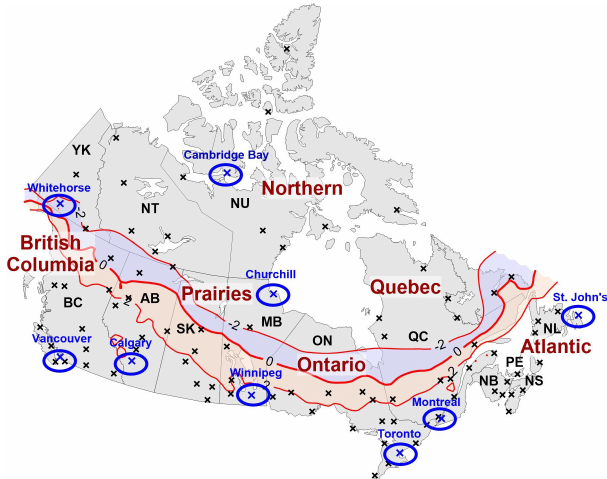
Figure 2. The 92 stations used in the analysis (see text for details). Blue crosses show the nine selected stations across Canada. The British Columbia region includes all stations in British Columbia (BC); the Prairies region includes all stations in Alberta (AB), Saskatchewan (SK), and Manitoba (MB); the Ontario region in- cludes all stations in Ontario (ON); the Quebec region includes all stations in Quebec (QC); the Atlantic region includes all stations in New Brunswick (NB), Prince Edward Island (PE), Nova Scotia (NS), Newfoundland, and Labrador (NL-L); and the Northern re- gion includes all stations in the Yukon (YK), the Northwest Territo- ries (NT), and Nunavut (NU). The average annual 0, − 2, and 2 ◦ C surface temperature lines, computed from the 1981–2010 climate normals of 1619 locations (ECCC, 2019c), are also